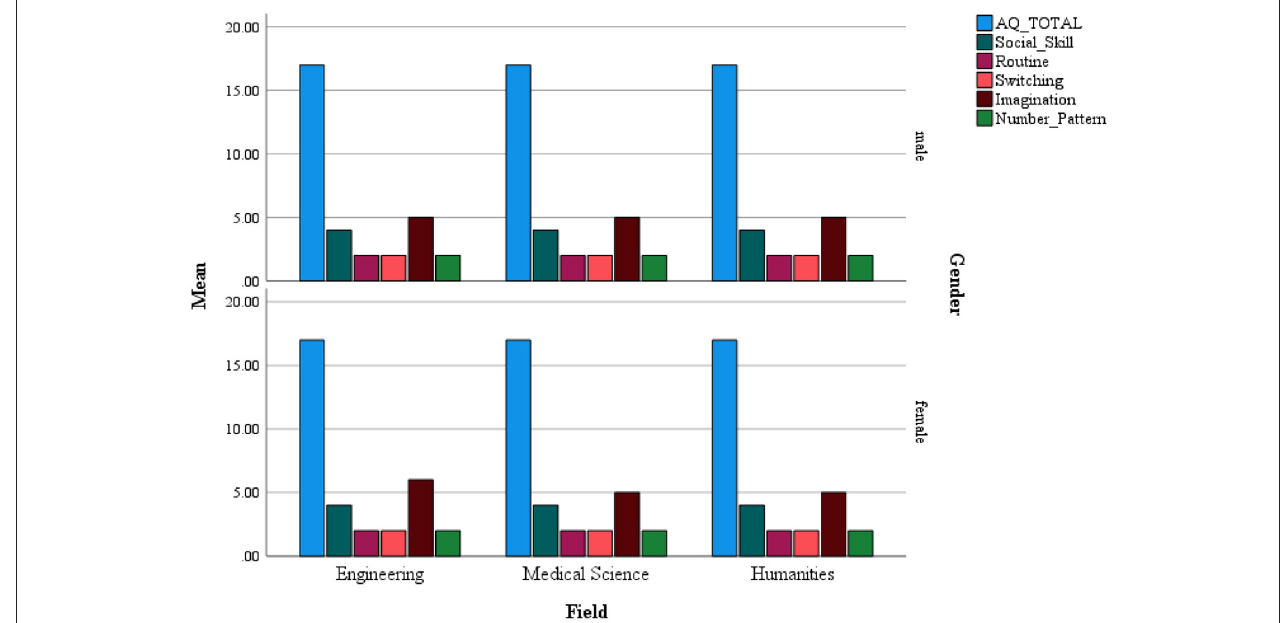
FIGURE 2 | Distribution of AQ scores across fields of study for males and